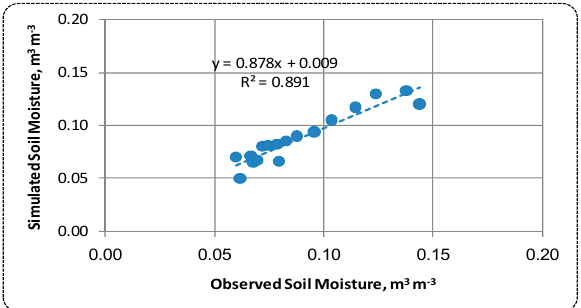
Figure 4. Soil moisture calibration for fresh irrigation water and 100% N during the 2017/2018 season.